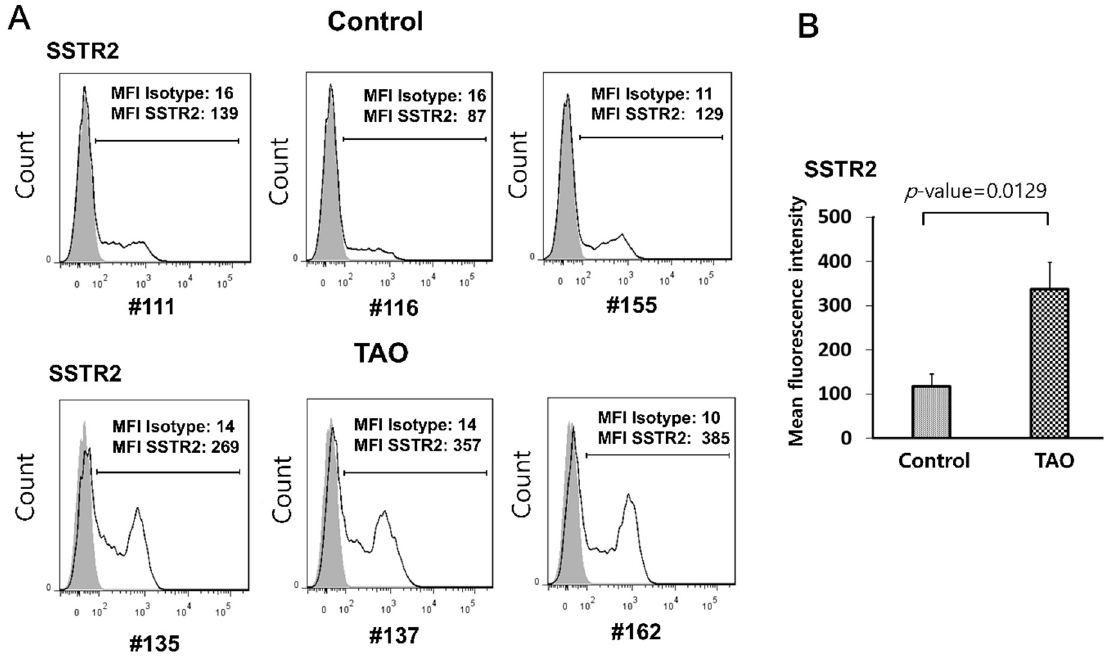
Fig 3. OFs from patients with TAO expressed higher levels of somatostatin receptor type (SSTR) 2. (A) OFs were plated at a concentration of 2 x 10 5 cells/well in a 6-well plate. After 24 hours, the levels of SSTR2 on the cell surface of OFs from control individuals (#111, #116, #155) and patients with TAO (#135, #137, #162) were examined by flow cytometry. The gray open histogram represents staining with isotype control antibodies. (B) Mean fluorescence intensity of SSTR2 was 2.85-fold higher in patients with TAO compared to control